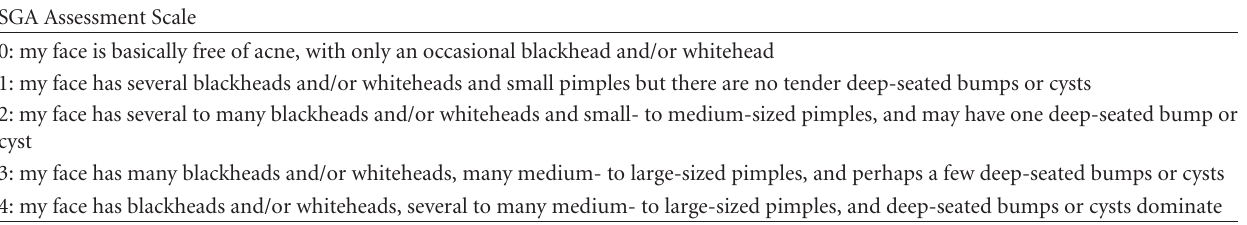
Table 2: Subject’s Global Assessment.